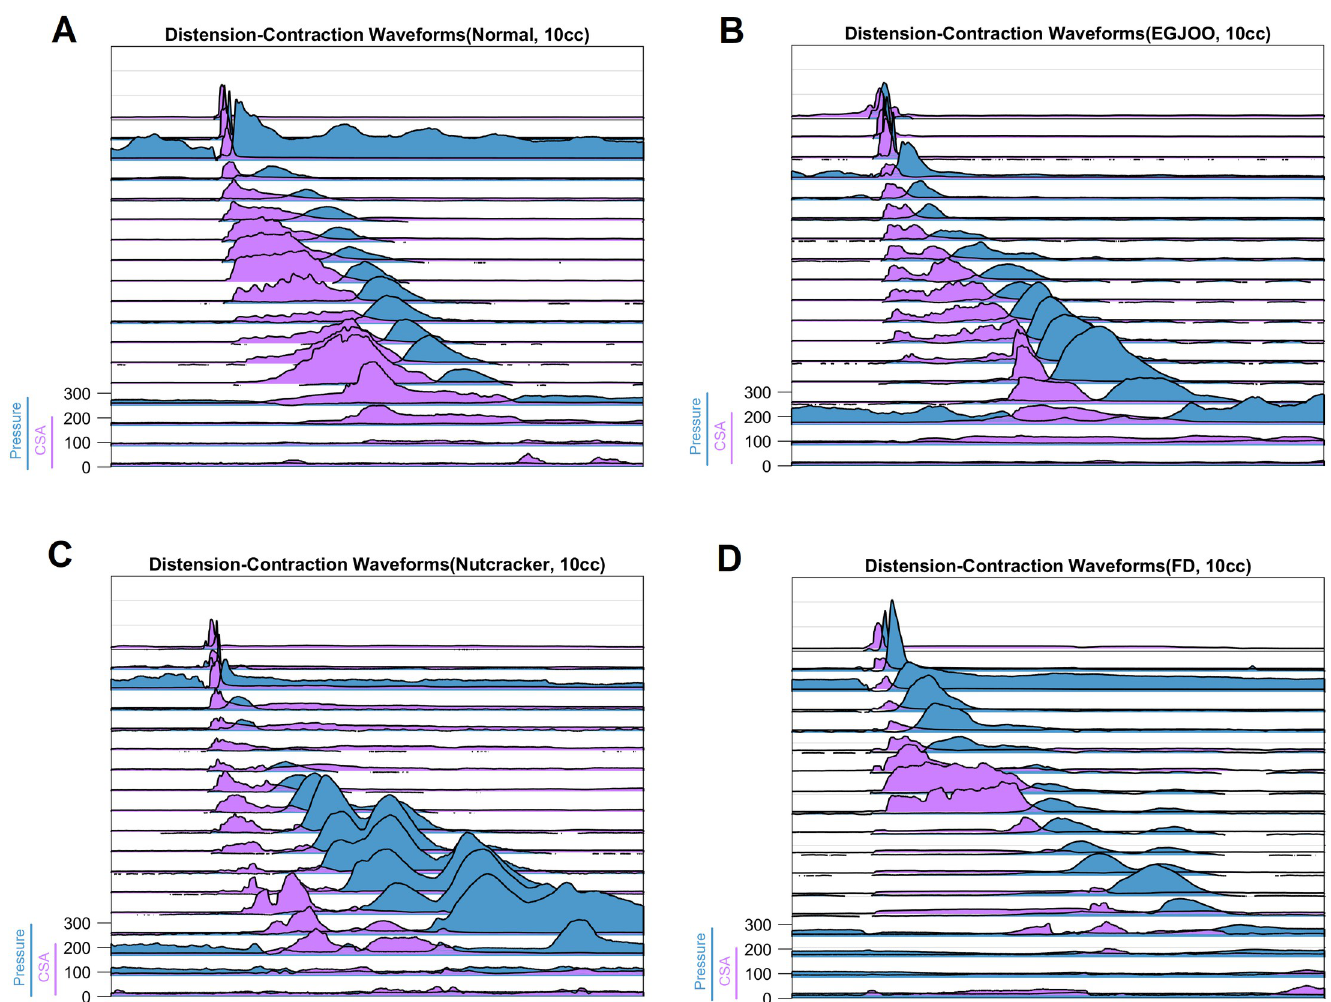
Fig 2. Distension-contraction plots of the pressure and impedance measurements of Fig 1. Both distension and contraction are displayed as waveforms in this figure. (A) normal subject, (B) patient with esophagogastric junction outflow obstruction (EGJOO), (C) patient with nutcracker esophagus (NC) and (D) patient with functional dysphagia. Note, that the amplitude of distension in patients is smaller and there is alteration in the temporal relationship between distension and contraction.